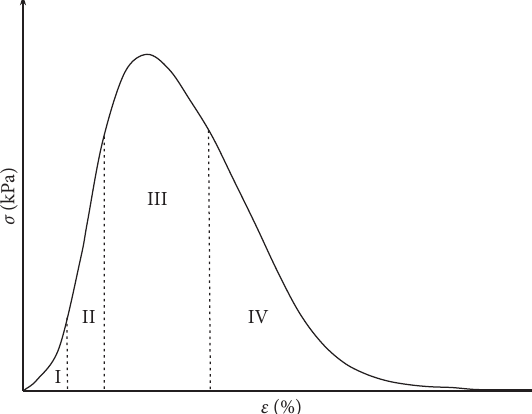
Figure 10: The characteristic curve of the stress-strain